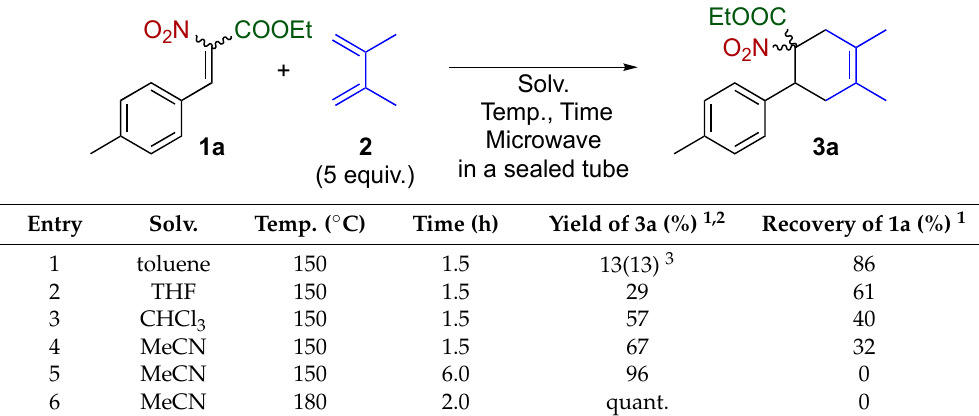
Table 1. Optimal conditions of the Diels–Alder reaction with ethyl α -nitrocinnamate 1a and 2,3- dimethyl-1,3-butadiene ( 2 ).